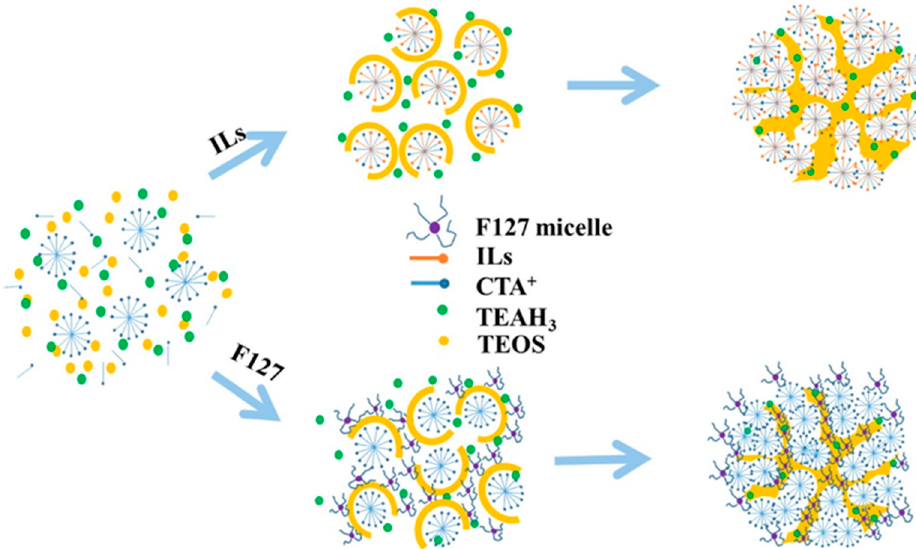
Figure 7. Mechanism for the synthesis of dendritic mesopores within silica nanoparticles with controllable particle size. Reproduced from Ref. [93] with permission from the ACS, 2014.